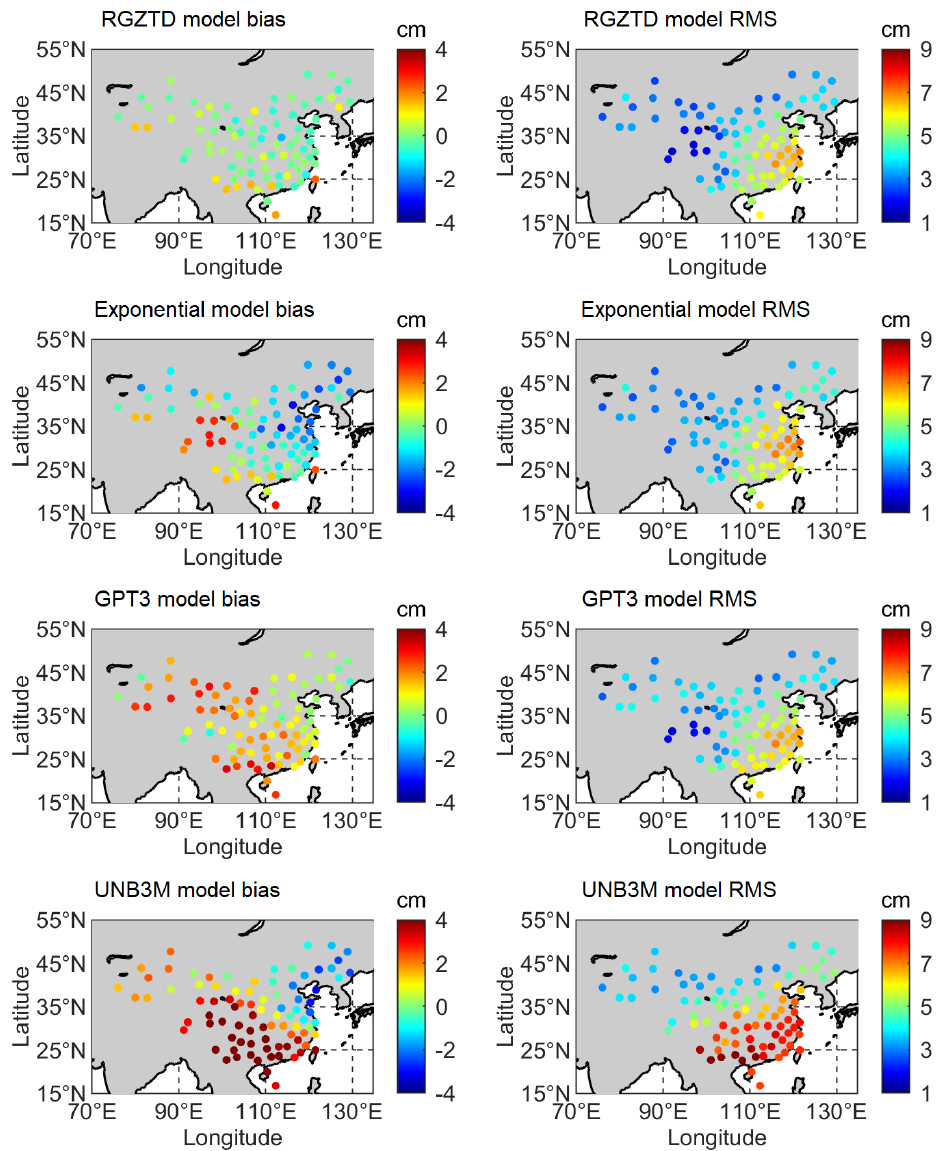
Figure 6. Distribution of bias and RMS of RGZTD model, Exponential model, GPT3 model and UNB3M model in China, where the radiosonde ZTD data is the reference value. Table 2. Mean bias and RMS of RGZTD model, Exponential model, GPT3 model with respect to radiosonde ZTD data in 2017–2018 [cm].